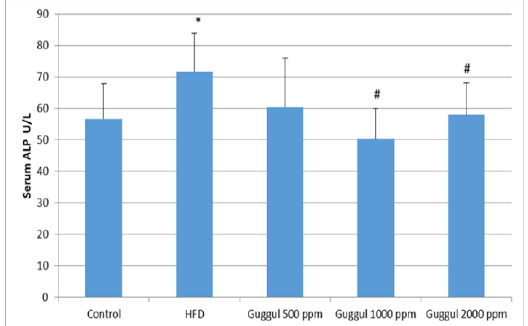
Figure( 7) Effects of guggulsterone on serum ALP level of mice models with high-fat diet induced NAFLD.